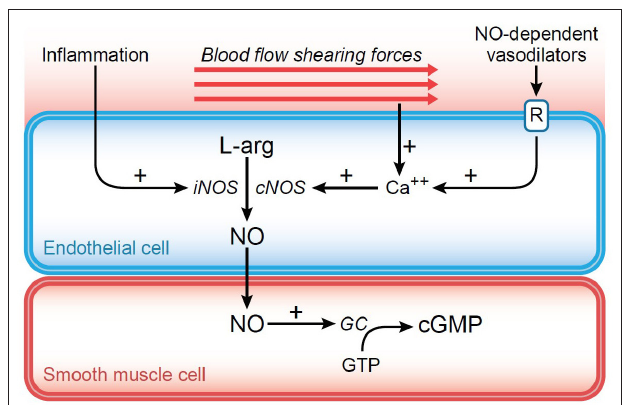
FIGURE 3 | Diagram representing the impact of shear force generated against the endothelium. Through mechanotransduction, intracellular calcium is increased leading to increased nitric oxide (NO) production from stimulation of constitutive nitric oxide synthetase (cNOS). NO diffuses into surrounding smooth muscle cell causing activation of guanylyl cyclase (GC) and conversion of guanosine triphosphate (GTP) into cyclic guanosine monophosphate (cGMP). The resulting decrease in cytosolic calcium causes relaxation of vascular smooth muscle and